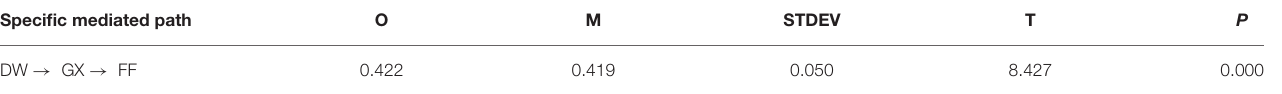
TABLE 7 | Results of the specific mediated path test. Specific mediated path O